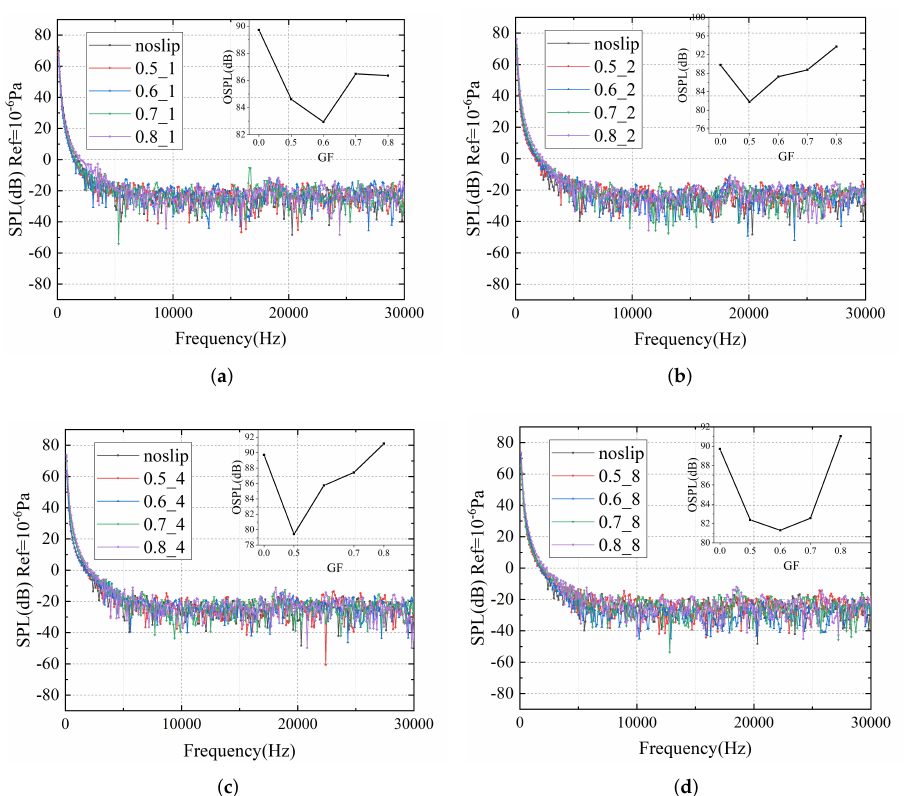
Figure 19. Comparison of frequency spectra for GF at Strip number = 1,2,4,8. ( a ) GF = 0.5.